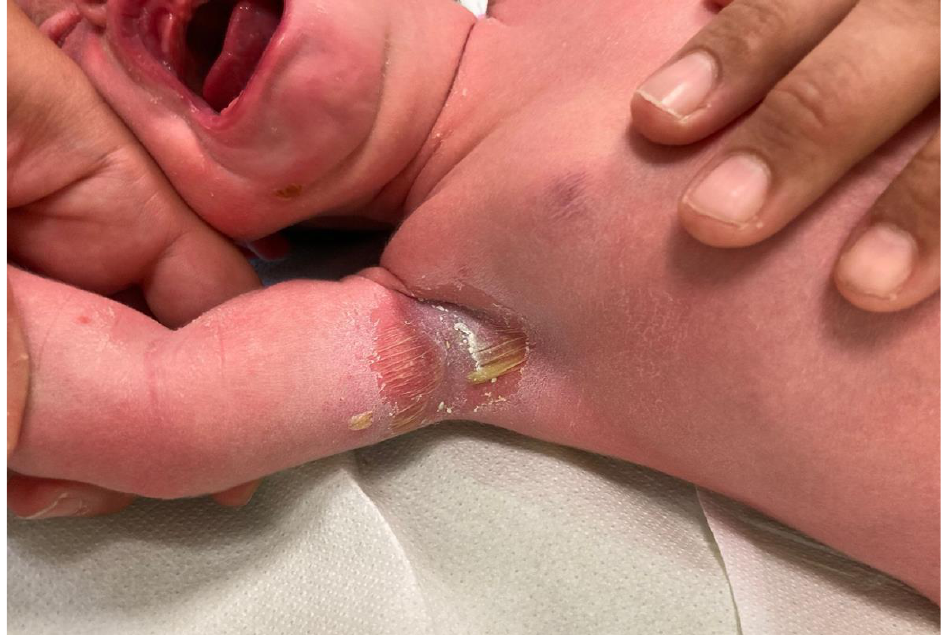
Figure 2. Case of SSSS in a neonate, with diffuse erythema and skin exfoliation at the level of the cubital fold and fluid-filled blisters that are thin-walled and easily ruptured.